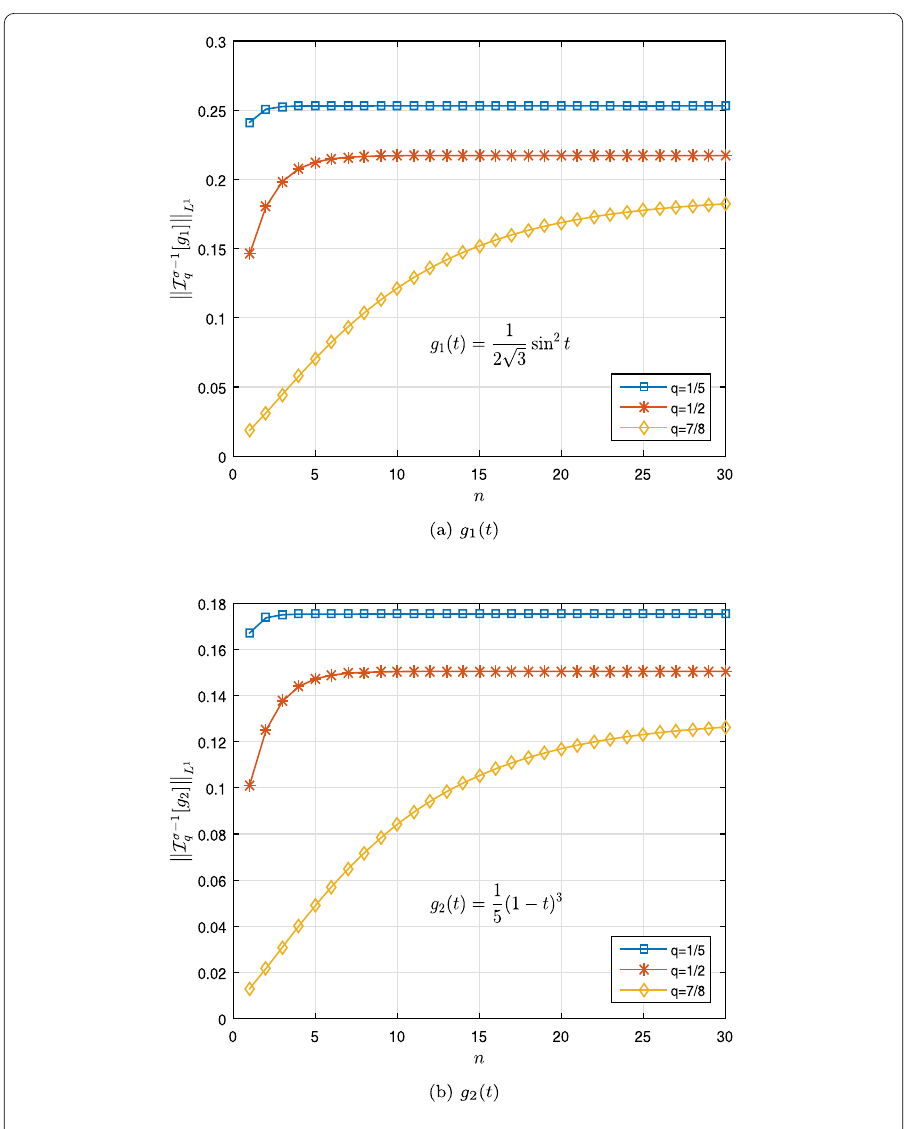
Figure 1 Graphical representation of (cid:13) I σ –1 q [ g i ] (cid:13)